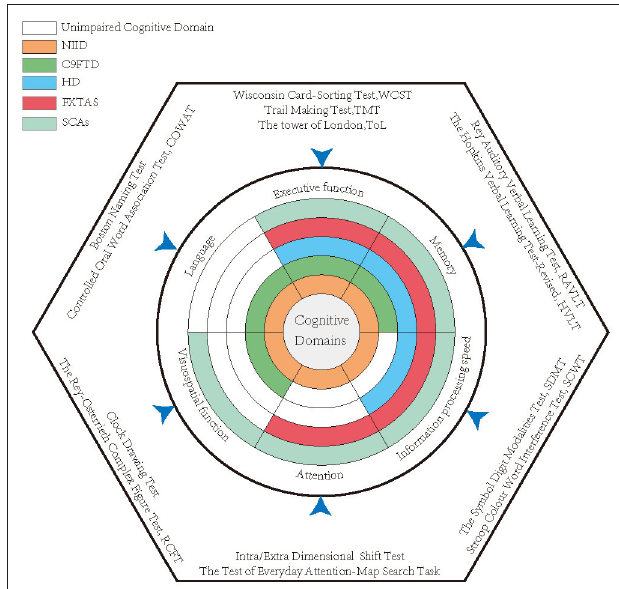
FIGURE 2 | The impaired cognitive domains of each disease and the most classical quantitative scales used in studies. Each annulus represented a disease, and the colored areas indicate the impaired cognitive domains, while the white zones reveal relatively intact cognitive